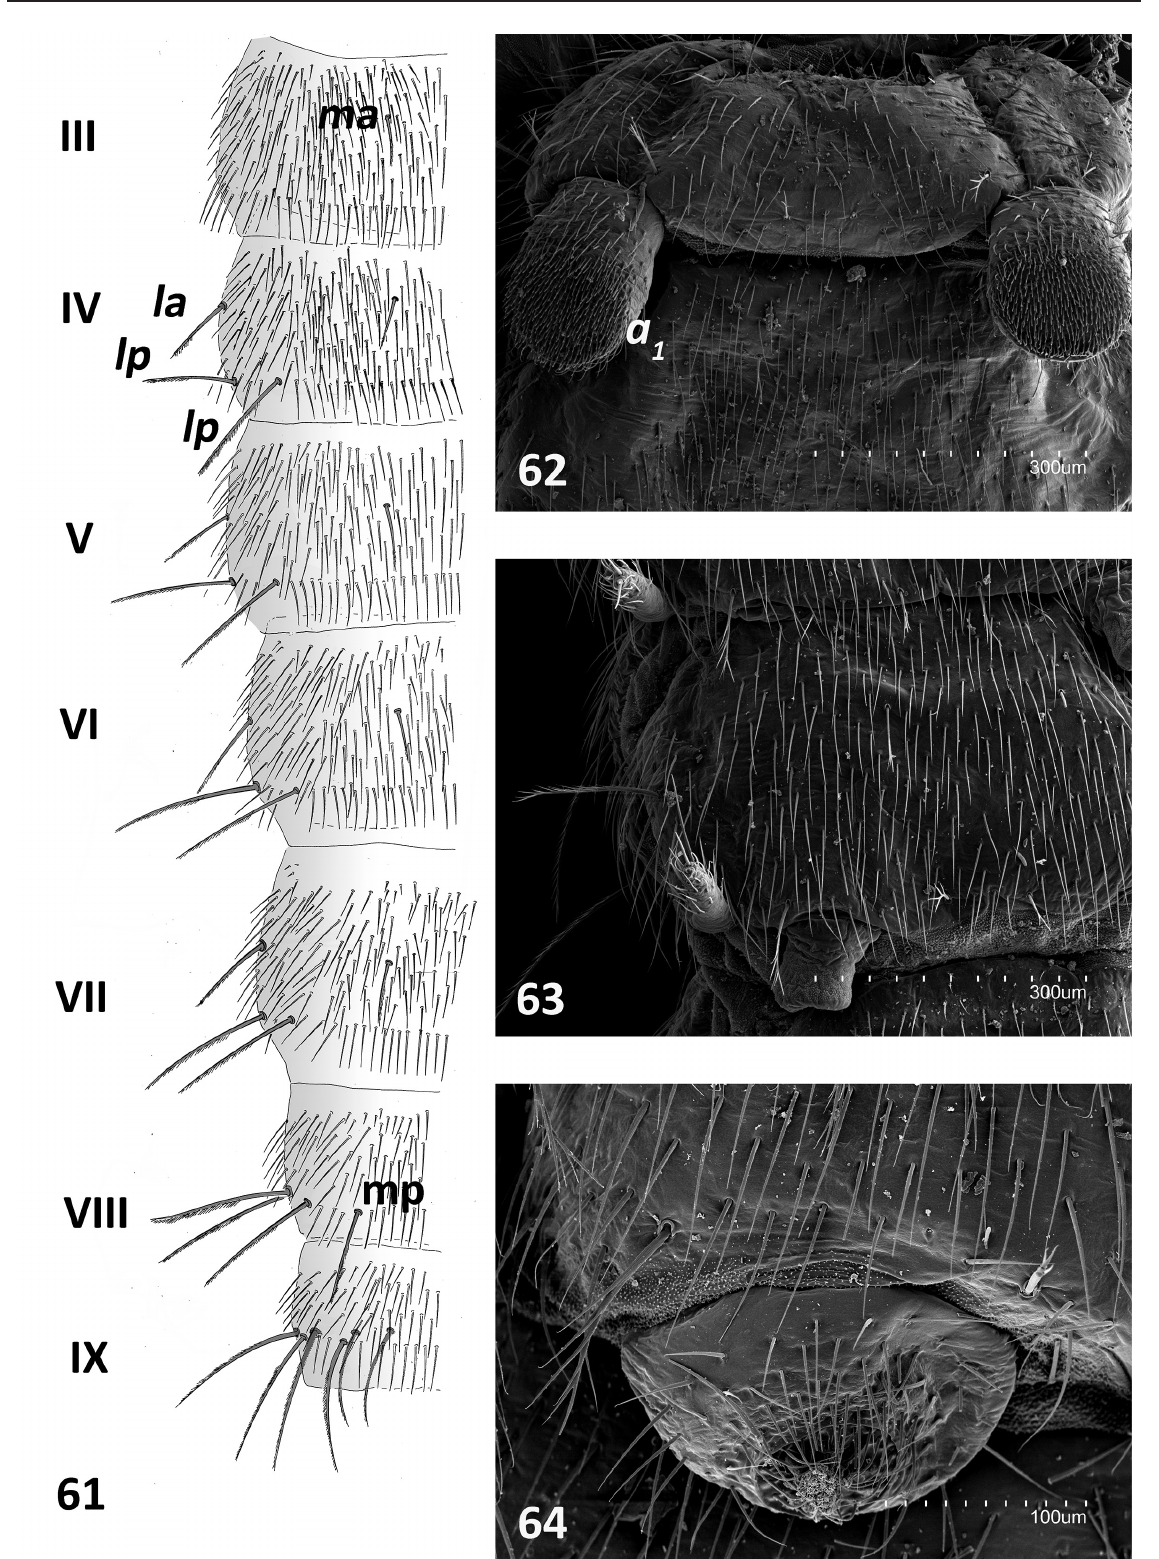
Figs 61‒64. Pacificampa wudonghuii Sendra sp. nov. 61 . Urotergites III‒VIII and IX abdominal segment, left side (holotype, NEIGA-diplura-01). 62 . Male first urosternite with glandular a 63 . Fourth urosternite, right side. 64 . Male eighth